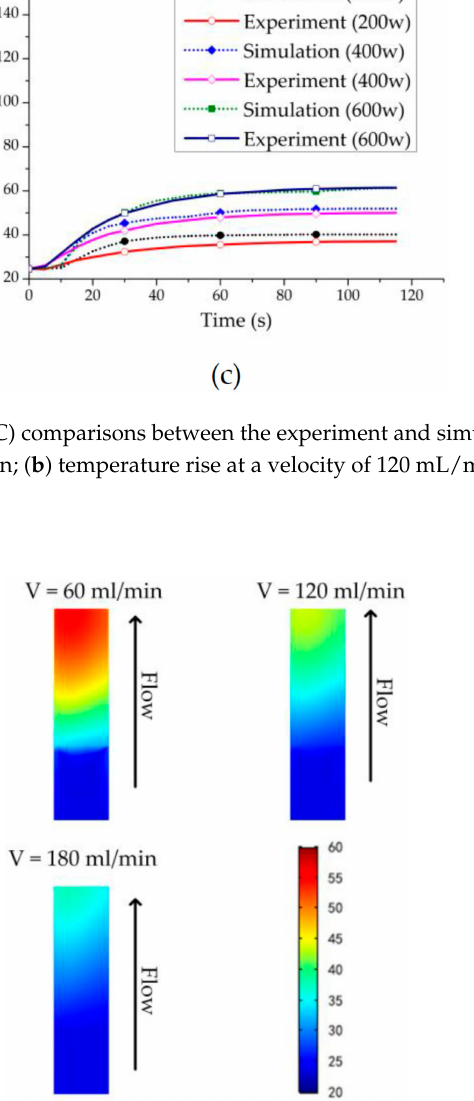
Figure 6. The cross-sectional temperature ( ◦ C) distribution at different velocities when the microwave power is 200 W in the simulation.